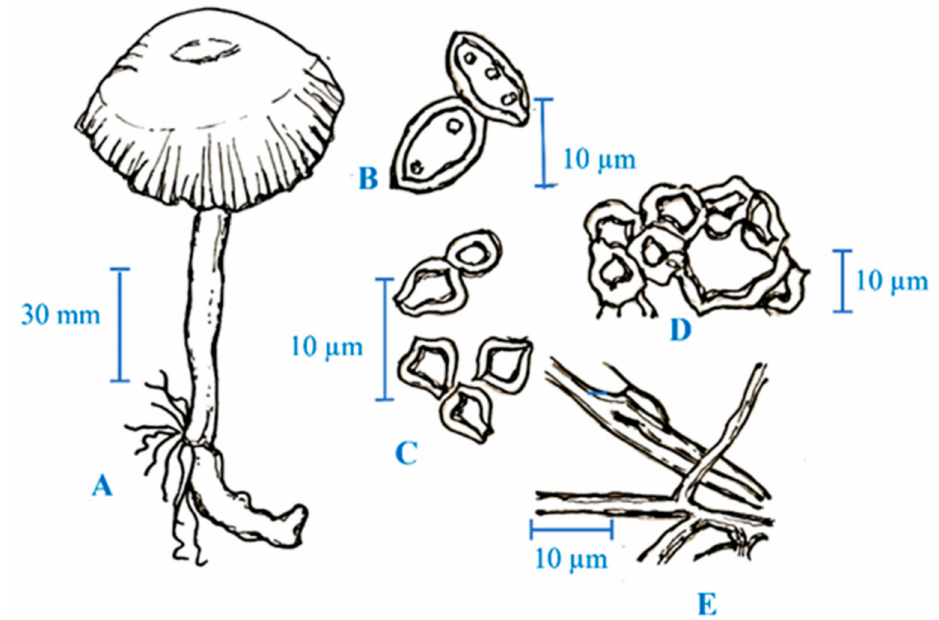
Figure 1. ( A ) Psilocybe subaeruginosa ; ( B ) basidiospores; ( C ) subrhomboid basidiospores; ( D ) radial pileus trama; ( E ) setoid hyphae.